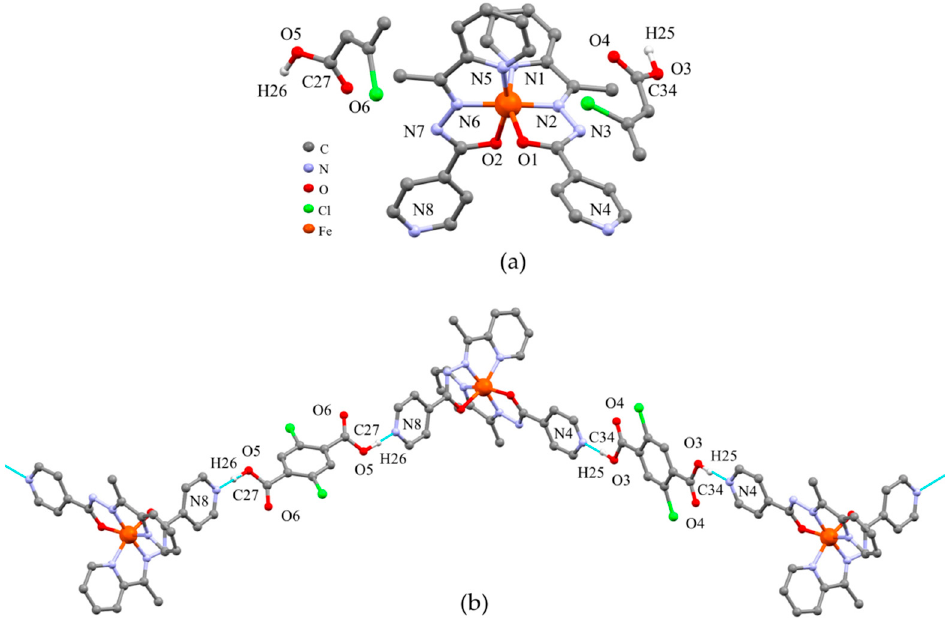
Figure 1. ( a ) Asymmetric unit of 1-Cl ; ( b ) Molecular arrangements of [Fe(L) 2 ] and H 2 Cl 2 TPA in zig-zag hydrogen bonded chain.